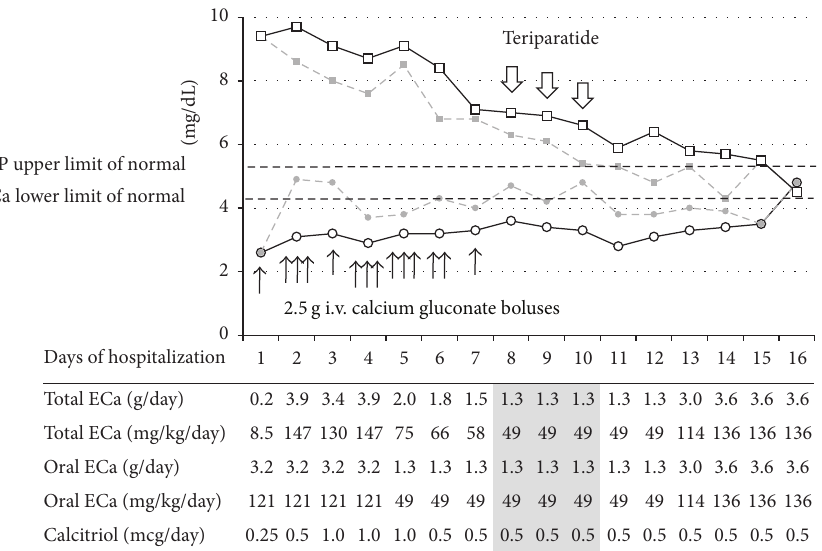
Figure 1: Trends in serum ionized calcium and phosphorus levels in a 10-year-old girl with hypoparathyroidism over the course of hospitalization. Minimum and maximum daily levels of iCa (circles and solid and dashed lines, resp.) and P (squares and dashed and solid lines, resp.) are shown. Black arrows indicate individual calcium gluconate boluses (2.5g each). Open arrows point to once daily subcutaneous administration of teriparatide. Oral supplementation consisted of calcium carbonate except for Days 5–12 when calcium glubionate was given. ECa, elemental